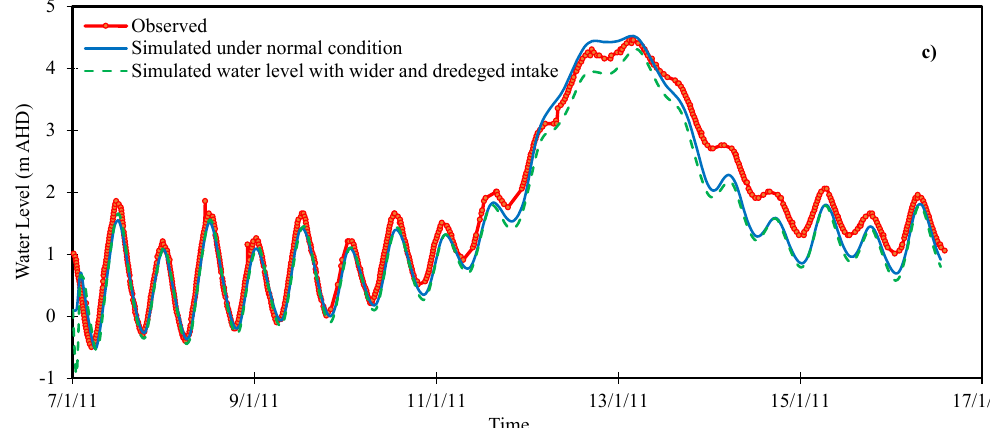
Figure 10. ( a ) Flow distribution at BRE under normal condition; ( b ) after widening of the right channel; ( c ) Comparison of water levels at the Brisbane city gauge before and after widening of the right channel.